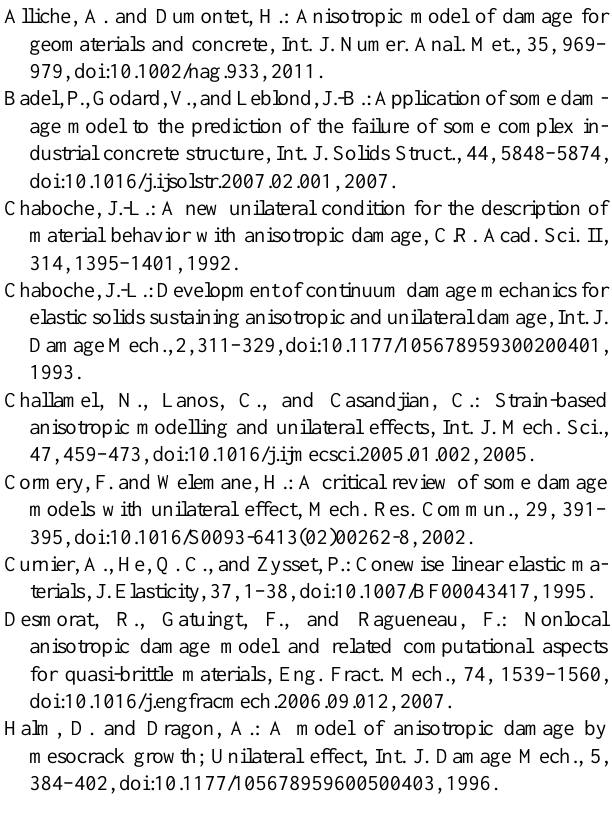
the damage threshold strain in compression (( (cid:15) 1 ) c = 10 − 3